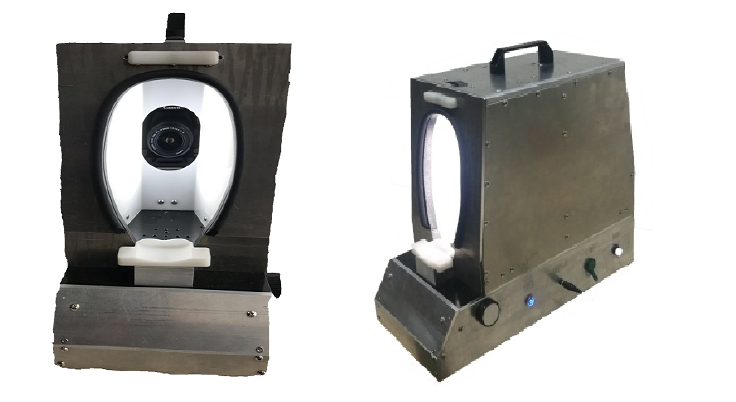
Figure 4. Appearance of the capturing